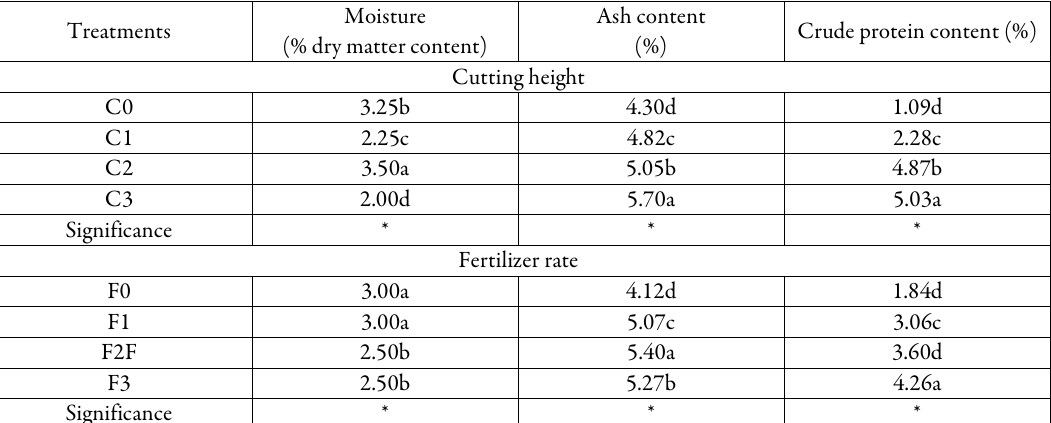
Table 6. Effect of cutting heights and fertilizer application on moisture, ash, and crude protein contents Amaranthus cruentus L. Treatments